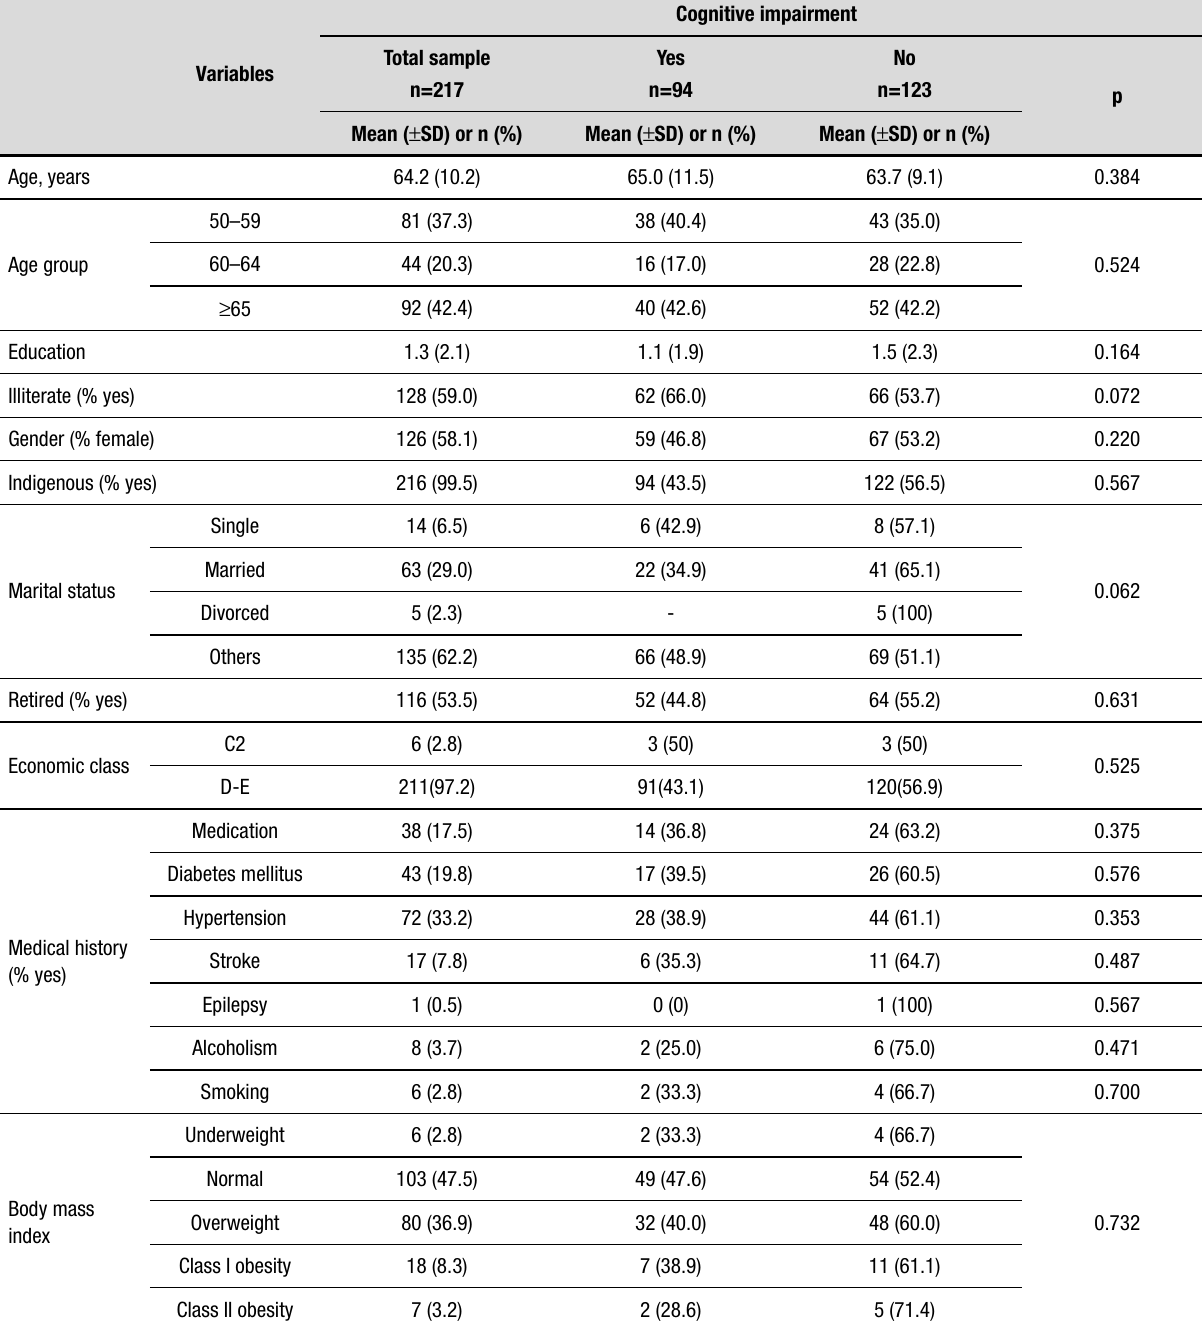
Table 1. Sociodemographic characteristics and medical history for total sample and according to cognitive impairment.